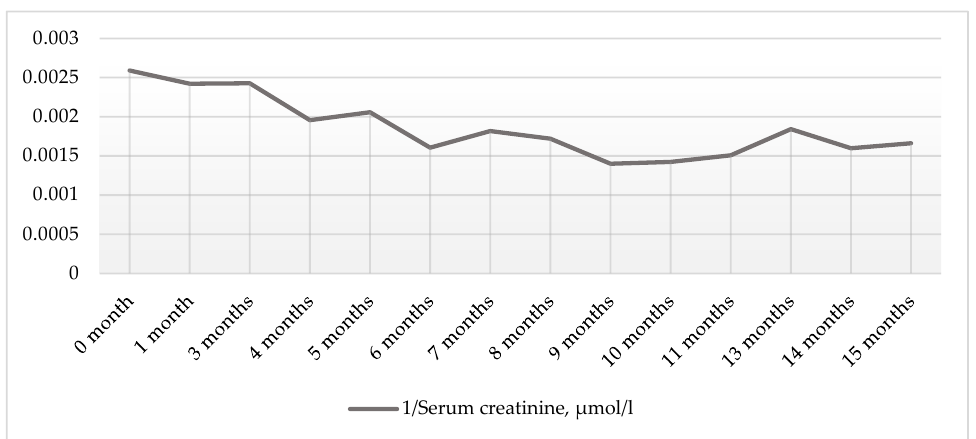
Figure 3. Course of renal function after transferring to a tertiary care nephrologist. Note: Kidney function was evaluated as 1/creatinine level (grey line). The 0 month marker represents the beginning of regular visits to a tertiary care nephrologist in May 2021 (SCr—386 µ mol/L). The patient is under the supervision of a tertiary care nephrologist until present. The figure shows data on kidney function for 15 months (until August 2022) (SCr—602 µ